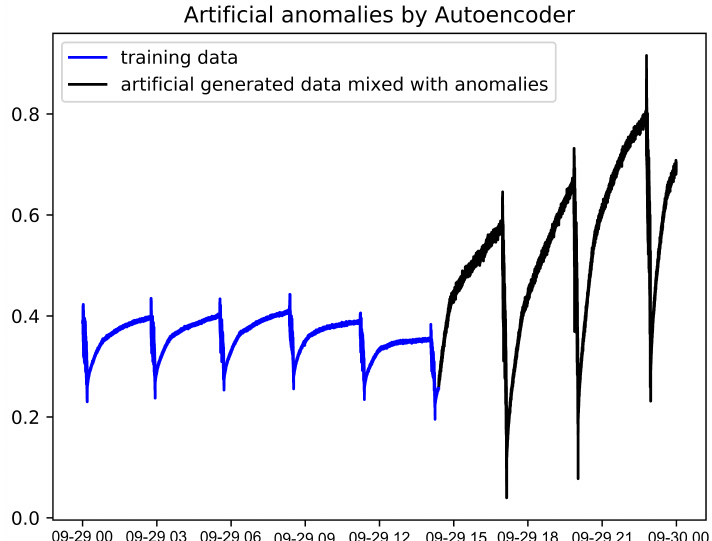
Figure 4. Illustrated graph of the water level dataset after mixing with artificial anomalous